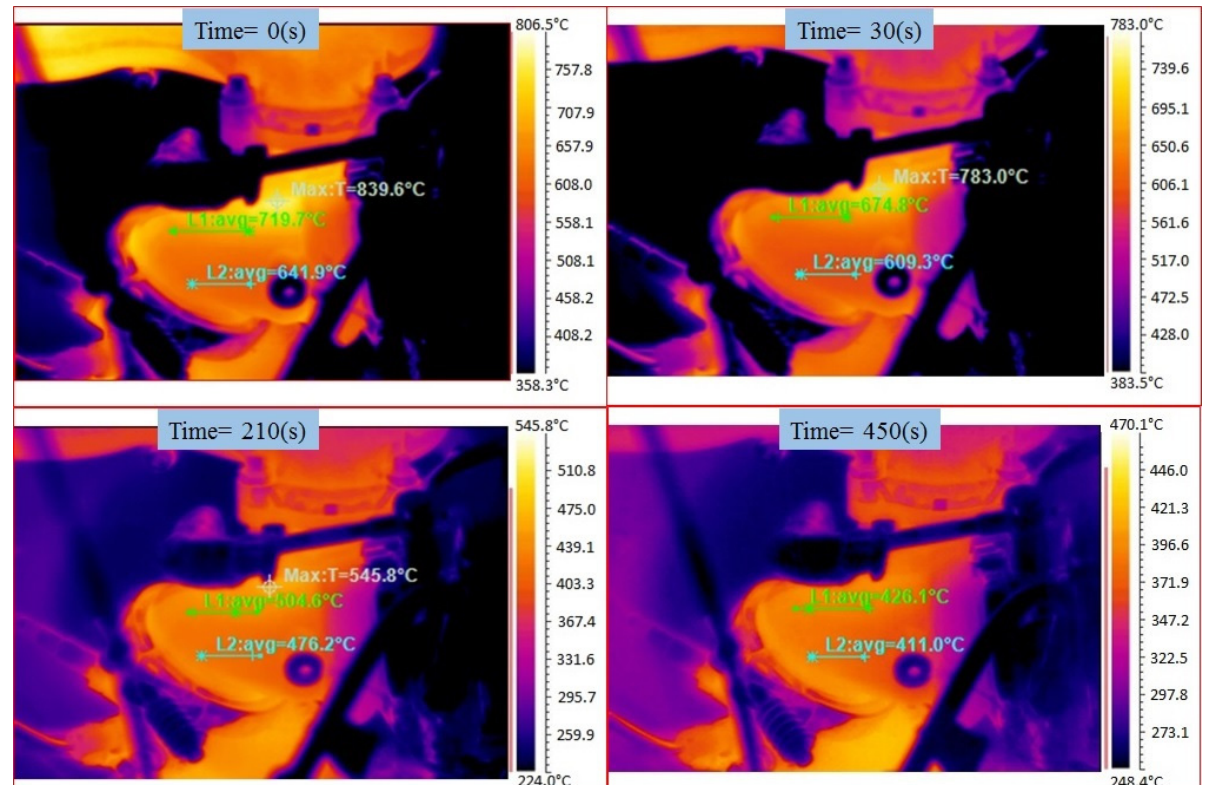
Figure 15. Variation in cool-down temperatures with time according to thermal camera images.